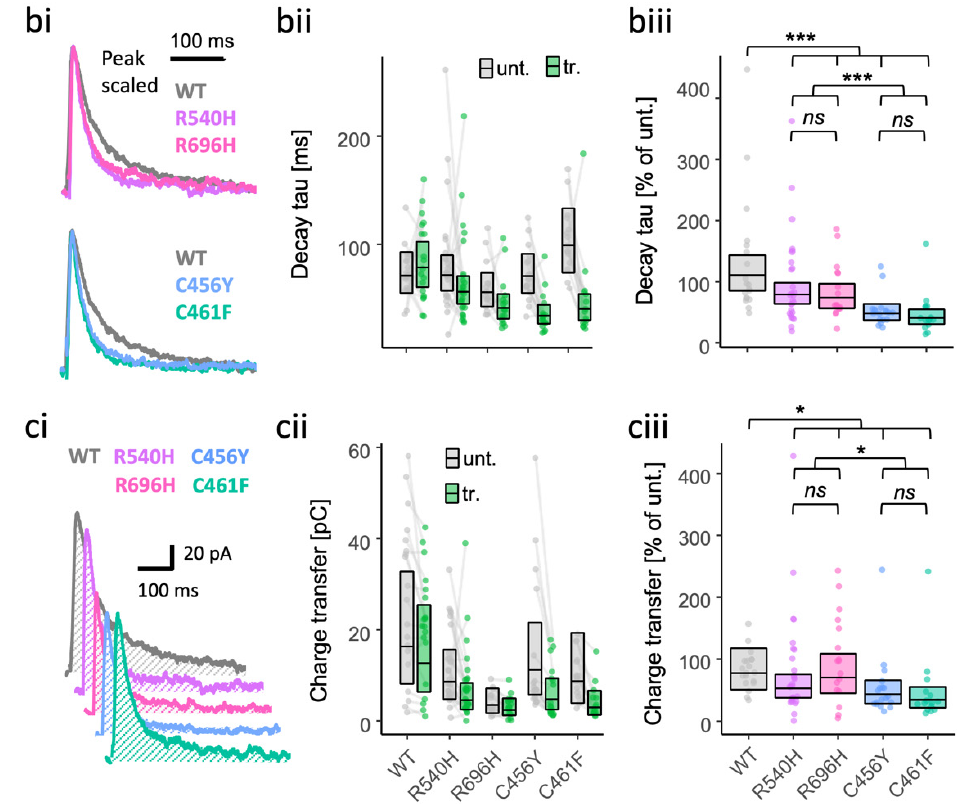
Figure 2. Gain- and loss-of-function GluN2B mutants are both associated with more rapidly decay- ing NMDA-EPSCs in GluN2B knockout neurons. NMDA-EPSC +20 mV peak amplitudes ( a ), decay decaying NMDA-EPSCs in GluN2B knockout neurons. NMDA-EPSC +20 mV peak amplitudes